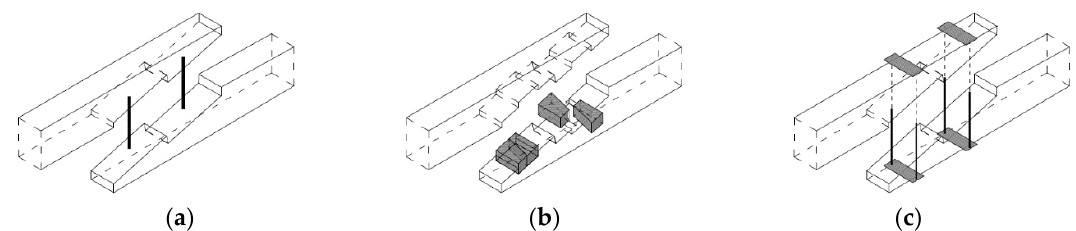
Figure 9. Schemes of the experimental testing models: ( a ) series E — with 2 drawbolts (double-sided tooth plate connectors type C10 + M10 screws), ( b ) series F — with wood inserts (and additional steel clamps), ( c ) series G — with steel clamps.